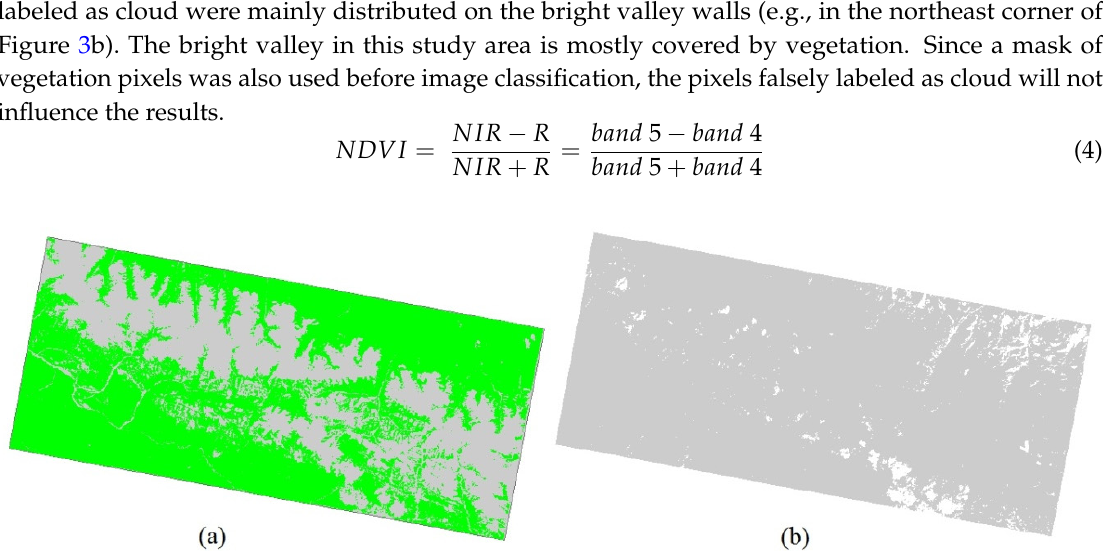
Figure 3. ( a ) Vegetation pixels in green with 0.4 < normalized difference vegetation index ( NDVI ) < 1.0; and ( b ) cloud pixels in white with 0.35 < reflectance of NIR < 1.0 in the study area.